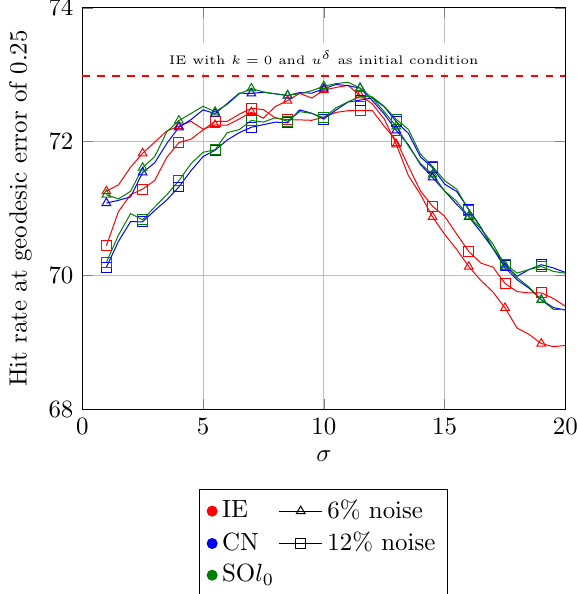
Figure 17. We solved the damped wave equation ( k = 5 10 − 2 ) with the Gaussian initial condition. · Then, we computed the hit rate at a geodesic error of 0.25 and plotted it over different values of σ . Additionally, we plotted the hit rate from the wave equation without damping obtained with δ -peak initial conditions and solved by the IE method as a red dashed line. The triangle and square denote a noise of 6% and a noise of 12%,